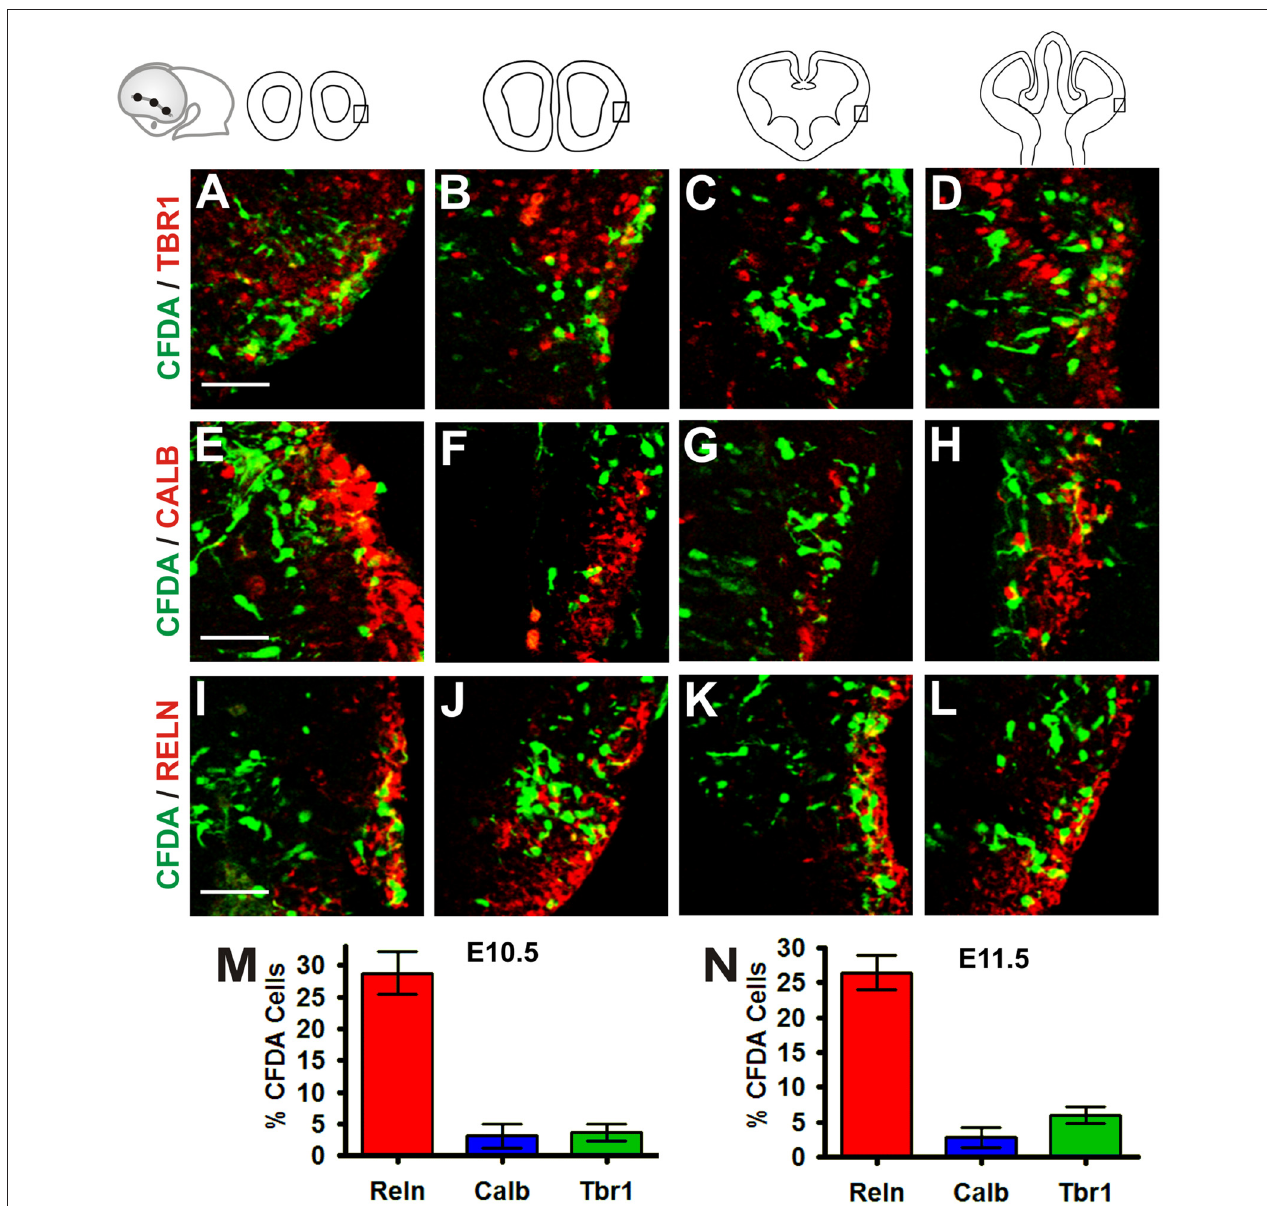
FIGURE 6 | Cells generated in the VP belong to different subpopulations of both pallial and subpallial origin. Immunohistochemistry (IHC) of telencephalic coronal sections from a representative cultured embryo (E11.5 + 24 h in culture) with antibodies to different markers: (A–D) pallial marker Tbr1, (E–H) subpallial marker Calbindin and (I–L) Reelin, marker of CR cells. (M,N) Proportion of CFDA + cells at E10.5 + 24 h in culture (M) and E11.5 + 24 h in culture (N) stages. At E10.5 + 24 h in culture, approximately 3.6% of CFDA-labeled cells expressed Tbr1, 3.1% expressed Calbindin, and 28.7% expressed Reelin (M) In E11.5 + 24 h in culture, 6% of labeled cells expressed Tbr1, 2.8% expressed Calbindin and 26.4% expressed Reelin (N) . Scale bar: 50 µ